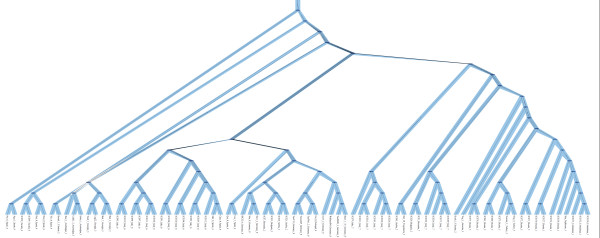
The reconciled tree. This tree was viewed as the evolved P/A tree inside the accession tree. The accession tree was shown in blue and the P/A tree in black. At the edges of branches were the accession names, countries and 8 regions where they were sampled. Most of the P/A tree vertices matched the accession tree vertices (dark blue ellipses) particularly in each geographic clade, which meant the P/A polymorphic pattern was associated with individual variation.